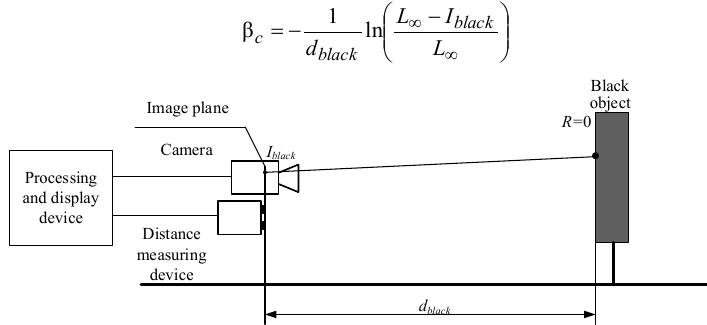
Fig. 5. Calibration of visibility range estimation